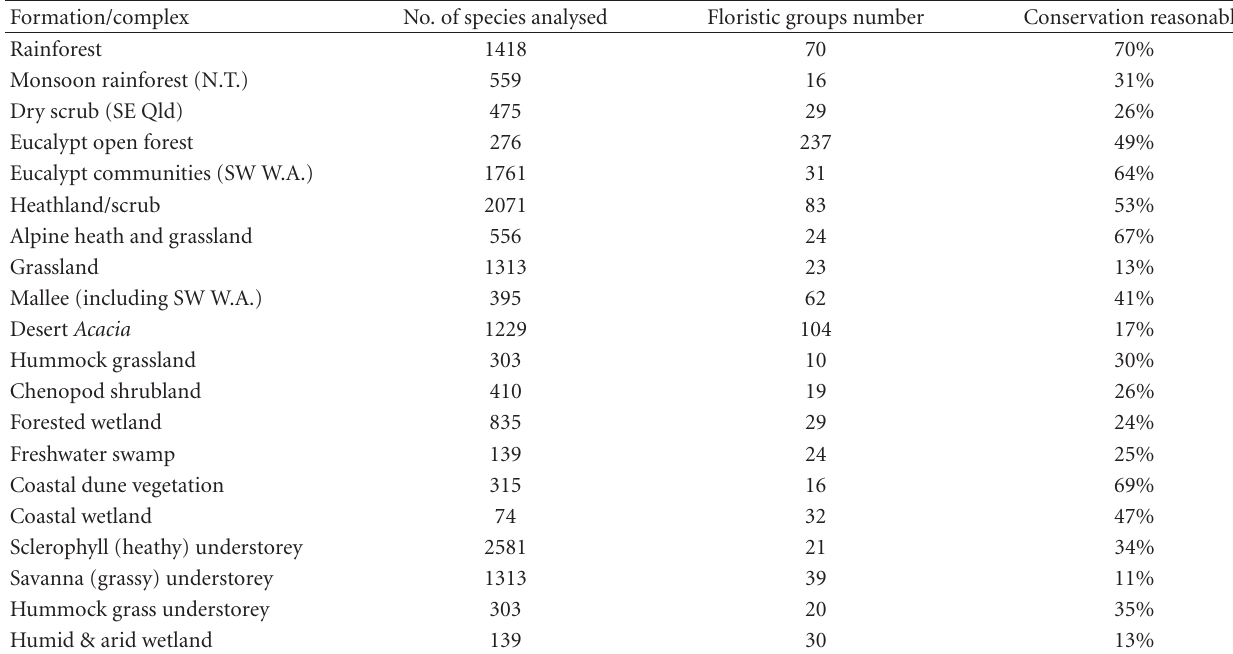
Table 1: The conservation status of major TWINSPAN Floristic Groups that contain the majority of plants and resident animals in Australia